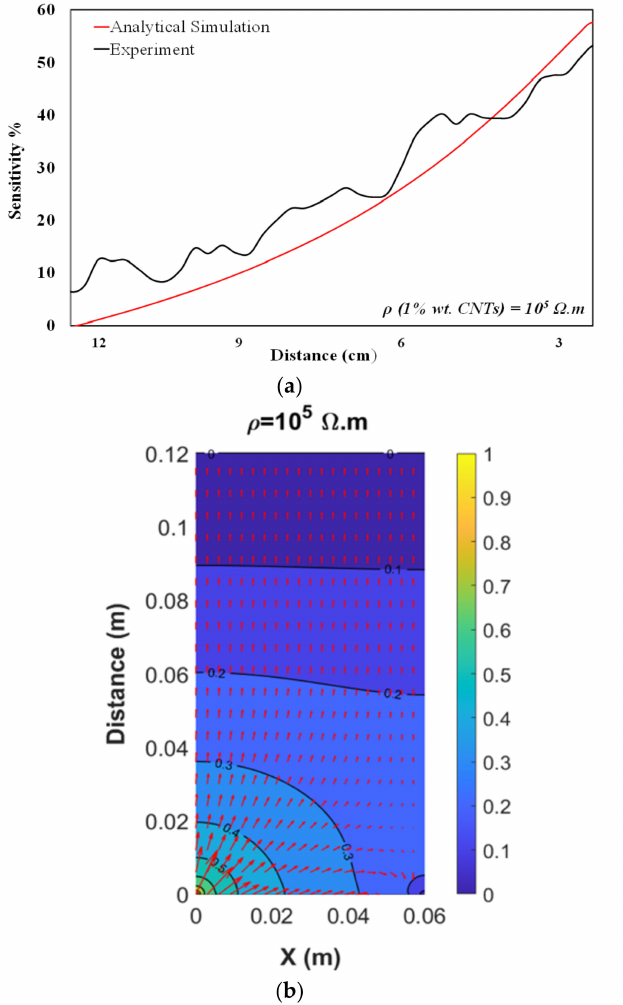
Figure 3. Sensing performance of the film sensor with 1% CNTs, ρ = 10 5 Ω m. ( a ) Sensitivity (change of capacitance to the initial) comparison simulation result versus experimental one. ( b ) Potential contour for the in-phase voltages between probes and object at the distance of 12